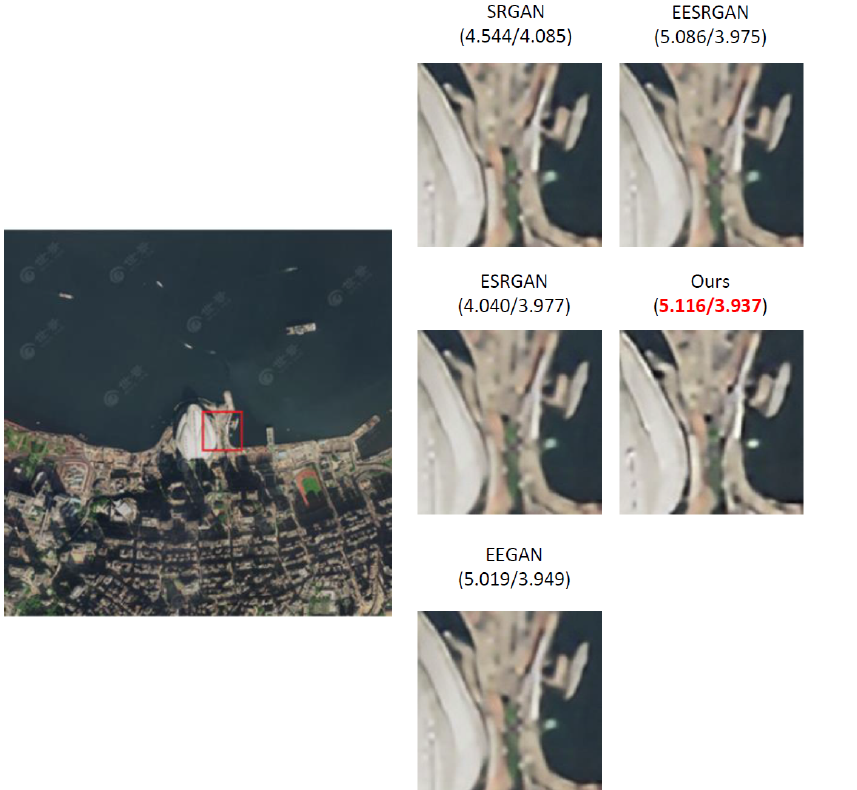
Figure 15. An enlarged partial view of the SR result of each method in the SpaceWill dataset—sample image 2, where the best results are shown in red